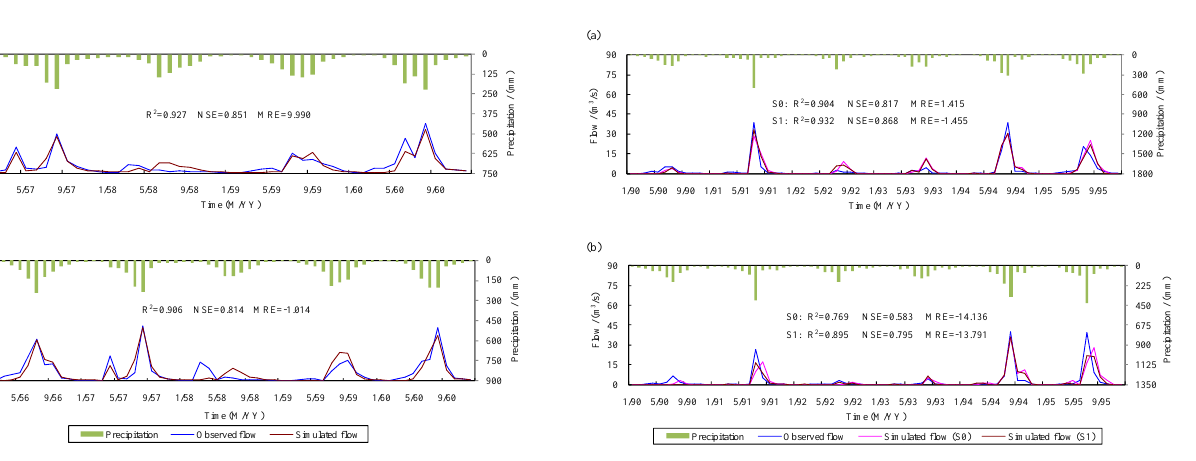
Fig. 5 Observed and simulated monthly streamflows during the physical parameter calibration period (before 1960) at two discharge gauges: (a) Yangzishao and (b) Wudaogou, where R 2 is the coefficient of determination; NSE is the Nash-Sutcliffe efficiency; and MRE (%) refers to the mean relative error.